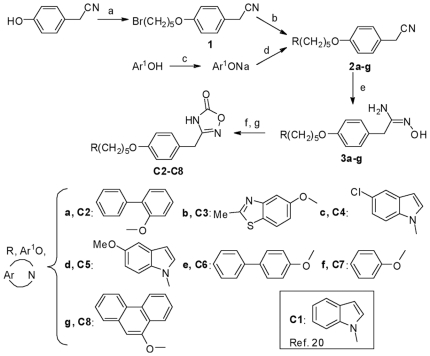
Synthesis scheme.Reagents and conditions: (a) Br(CH2)5Br, K2CO3, DMF, RT, 10 days; (b) Ar-NH, K2CO3, CH3CN, reflux; (c) NaOH, Abs EtOH; (d) 1, DMF, RT, 24 h; (e) NH2OH-HCl, K2CO3, Abs EtOH; (f) PhOCOCl, Et3N, CH2Cl2; (g) toluene, reflux. The terms 1, 2a-g and 3a-g written in bold refer to the C2-C8 precursors. The terms a to g written in bold in the bottom of the figure refer to the radicals (R) of the C2 to C8 compounds, respectively. The radical of the C1 compound is also shown.